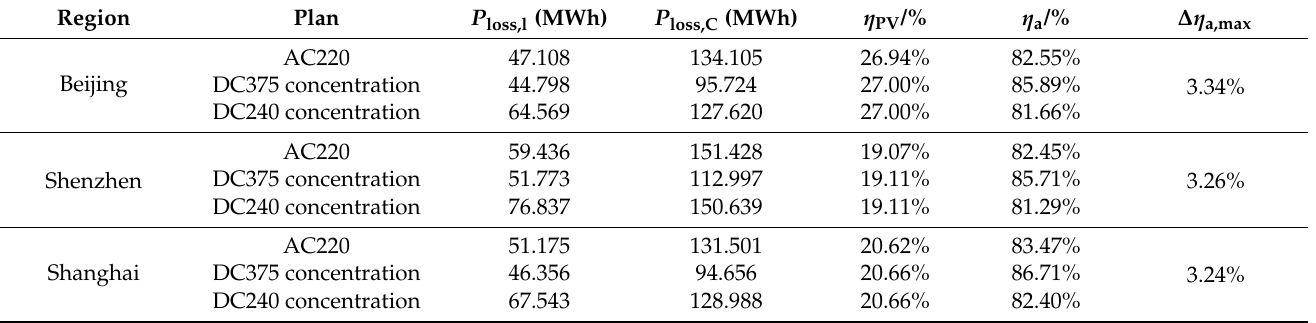
Table A4. Comparison of energy efficiency of educational buildings with different topologies in three